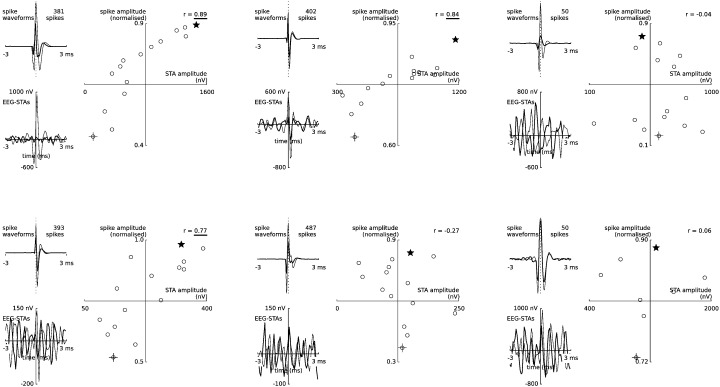
Co-variability between extracellular spike waveform amplitude and EEG-STA for each of the six cells shown in Fig. 2c. Pairs of discriminated extracellular spikes and concomitant spike-triggered EEG segments were split into 15 equally-sized groups according to the peak-to-peak spike waveform amplitude. Scatter plots depict the peak-to-peak amplitude of group-averaged spike waveforms and EEG-STAs; cross and star highlight two samples (light and bold lines, respectively) of spike averages (top left of each panel) and EEG-STA (bottom left). Although all six cells were associated with significant contributions to EEG, EEG-STAs of only three were correlated with variations of spike waveforms (correlation coefficient, r, in the upper-right corner; significant r underlined, p < 0.05). Positive EEG-STAs/spike amplitude correlations might indicate electrical coupling (‘cross-talk’) between ball- and micro-electrode recording channels.